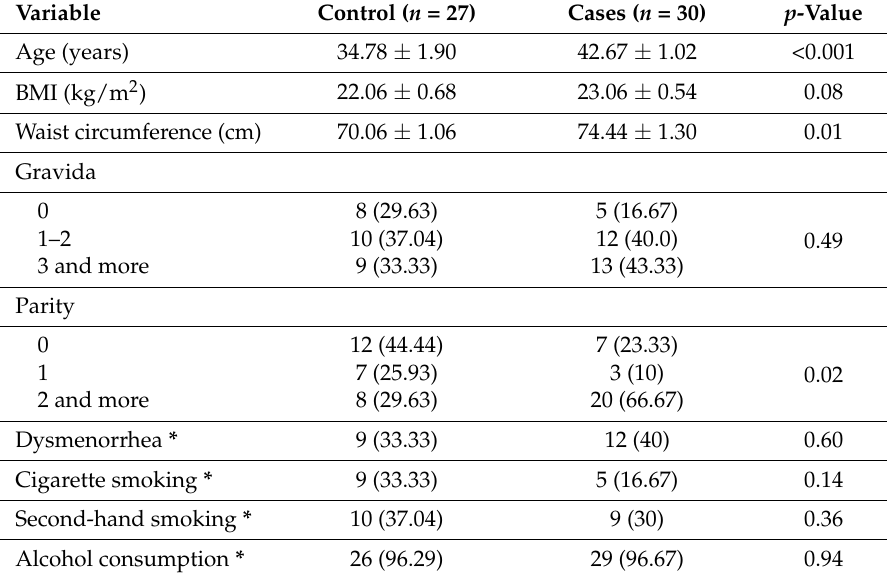
Table 1. Clinical characteristics of cases with uterine leiomyoma and